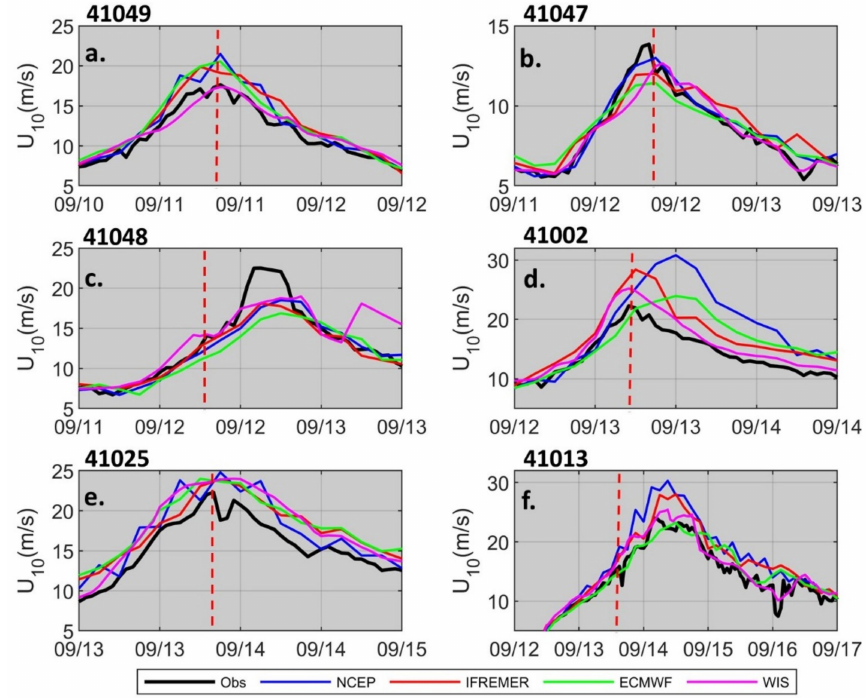
Figure 12. Buoy-model time-series comparisons of model wind input for buoys ( a ) 41049, ( b ) 41047, ( c ) 41048, ( d ) 41002, ( e ) 41025 and ( f ) 41013 during Hurricane Florence. The red dotted vertical line denotes the time used to assess the 1D wave spectra in Figure 13.